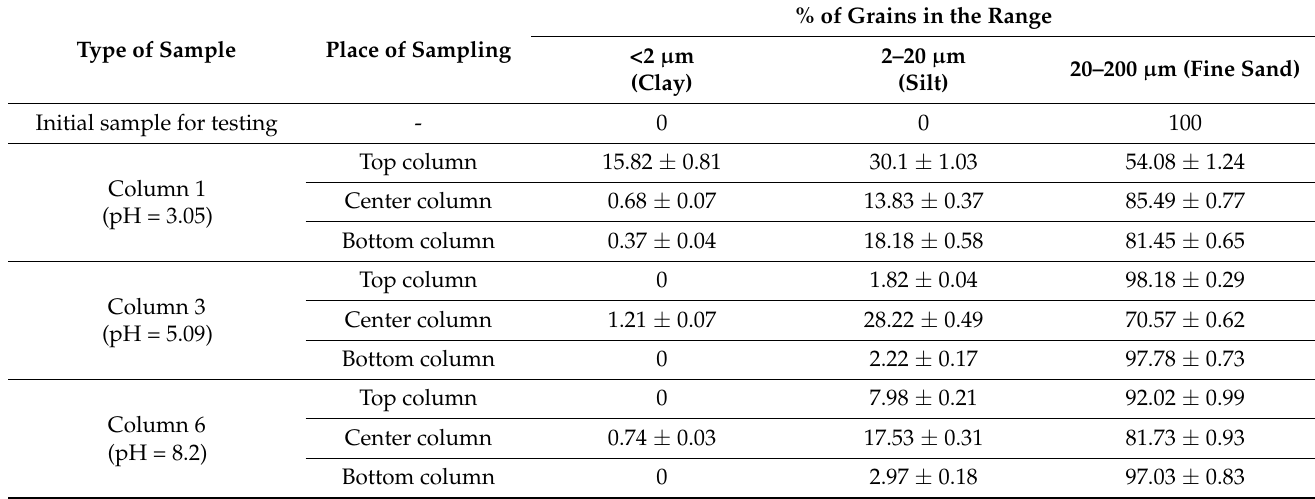
Table 5. Proportion of grains in the fraction at the indicated level: columns 1, 3, and 6 and in the starting material.